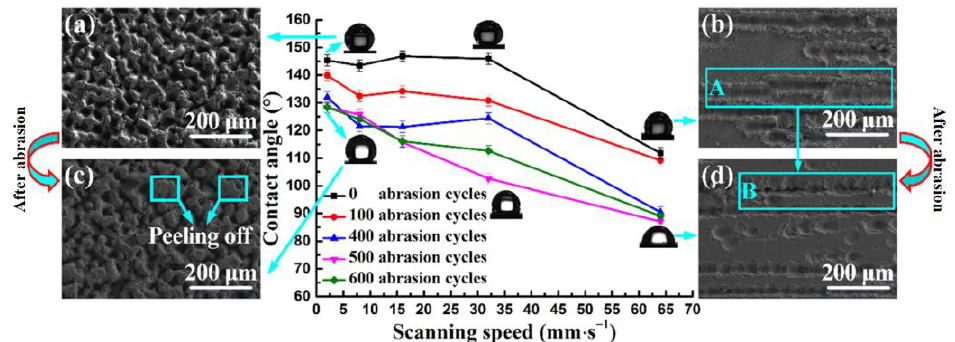
Figure 7. The influence of laser scanning speed on wettability (SEM images) [16]; ( a ) the hydro- phobic surface fabricated at 2 mm/s before abrasion; ( b ) the hydrophobic surface fabricated at 64 mm/s before abrasion; ( c ) the hydrophobic surface fabricated at 2 mm/s after 600 abrasion cycles; ( d ) the hydrophobic surface fabricated at 64 mm/s after 600 abrasion cycles.